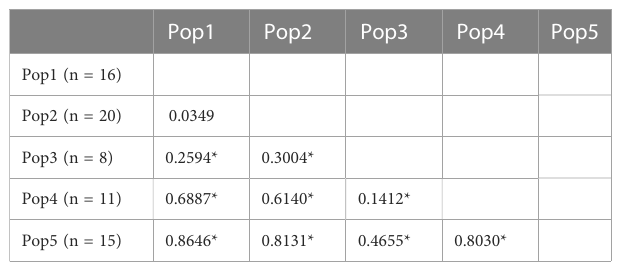
P values were obtained after 10,000 replicates. Populations: (1) W Korea/Dailan (Pop1), (2) S Korea/E Korea (Pop2), (3) Nanji Island/Taiwan (Pop3), Japan (Pop4), and British Columbia/ California (Pop5). *P < 0.01.